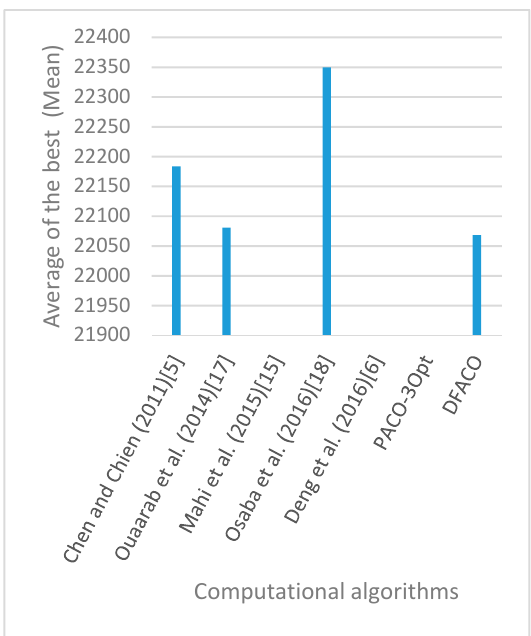
Figure 26. Average of best solutions obtained for instance kroE100 by all algorithms.